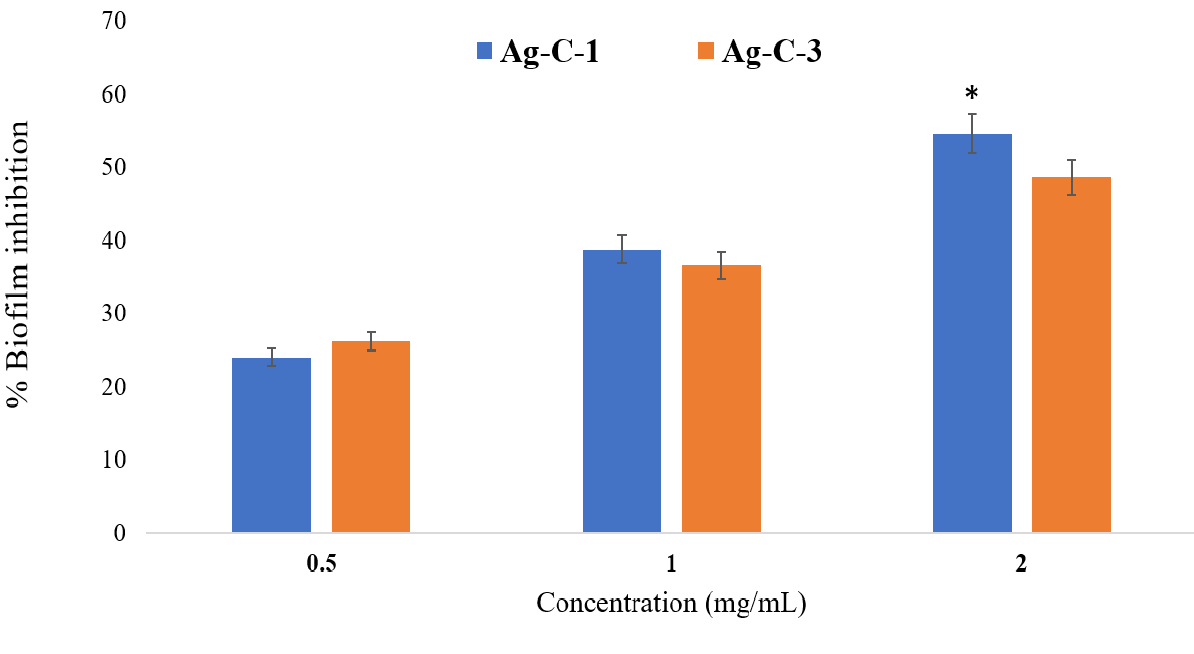
Cancer ranks as the second-leading cause of death worldwide. The International Agency for Research on Cancer (IARC) projected that there were roughly 18.07 million new cases of cancer and 9.5 million cancer-related deaths worldwide. Colorectal cancer (CRC), which includes colon and rectal cancer, is the third most common cancer in the world, following lung and breast cancer [55]. Using the as-synthesized Ag-C-1 and Ag-C- 3 nanohybrids, we aimed to assess their cytotoxic potential against human colorectal car- cinoma cell (HCT-116) by performing an MTT assay. Indeed, the MTT assay is employed to measure the viability of cells, treated and untreated, based on their metabolic activity through quantitating the NADPH-mediated cellular oxidoreductase enzymes, which re- duce the MTT dye into insoluble formazan. The MTT assay of HCT-116 cells treated with Ag-C-1 and Ag-C-3 nanohybrids (5–20 μg/mL) exhibited significant (* p < 0.05, ** p < 0.01) cytotoxicity after 24 h. The MTT results showed a 3 ± 0.2, 32 ± 0.6, 78 ± 0.3 and 91± 0.6% decline in viability of HCT-116 cell after exposure with 5, 10, 15 and 20 μg/mL of Ag-C-1 (Figure 9). Whereas, under identical conditions, the Ag-C-3 nanohybrids induced a 9 ± 0.5, 30 ± 0.4, 87 ± 0.6 and 93 ± 0.8% decline in cell viability, respectively (Figure 8). Furthermore, the linear curve fitting of the dose-dependent toxic trends of the Ag-CuO nanohybrids yielded IC 50 values at 11.78 μg/mL (R 2 = 0.9336) and 11.47 μg/mL (R 2 = 0.9162) for the Ag- C-1 and Ag-C-3 nanohybrids, respectively.